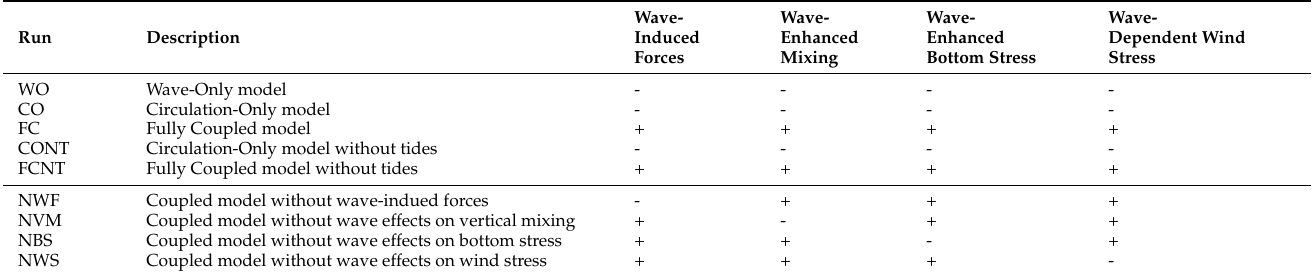
Table 1. Model configurations for a series of numerical experiments using